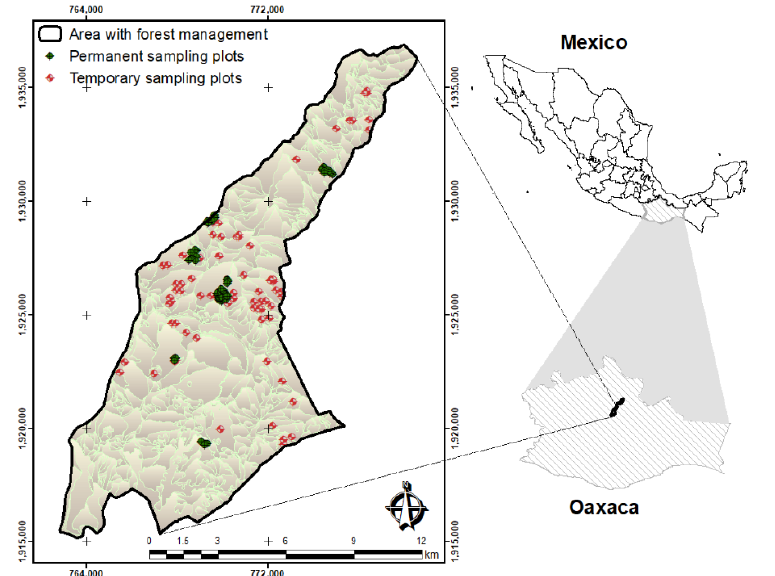
Figure 1. Study site location and sampled plots in Ixtlán de Juárez, Oaxaca, Southern Mexico. The most common soil groups found in the study area are acrisol, luvisol, and cambisol. humid with summer rains. The mean annual temperature is around 20 ◦ C, and the rainfall ranges from 800 to 1200 mm